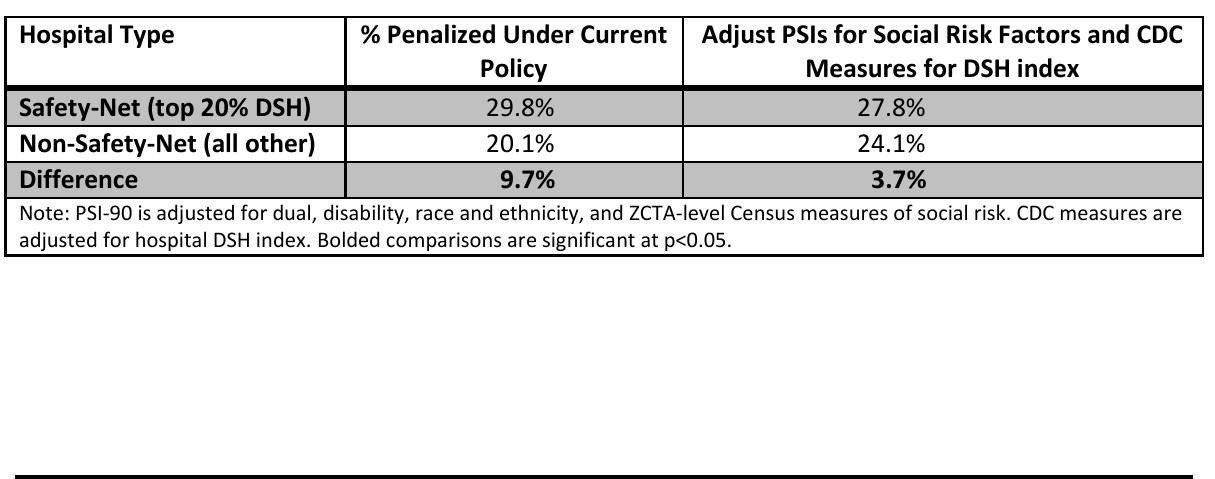
Table 6.14: Percent Penalized After Adjusting PSIs for Social Risk and CDC measures for DSH